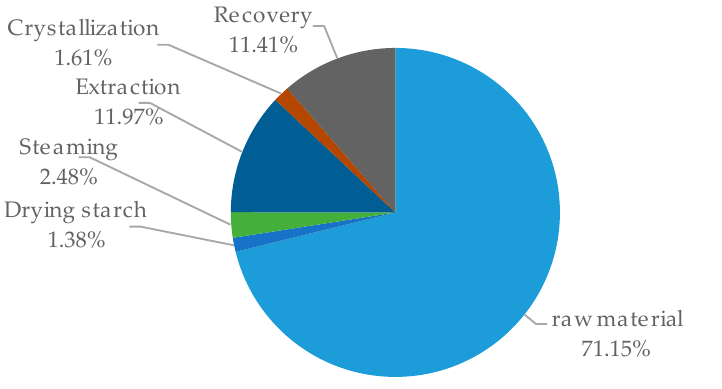
Figure 10. Distribution of operating costs.